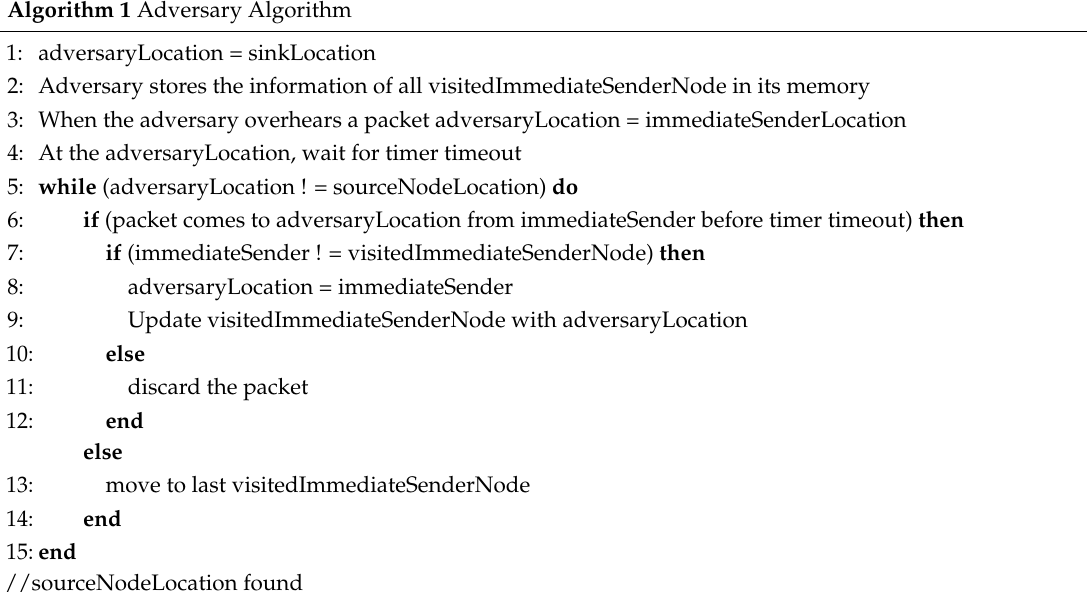
Algorithm 1 Adversary